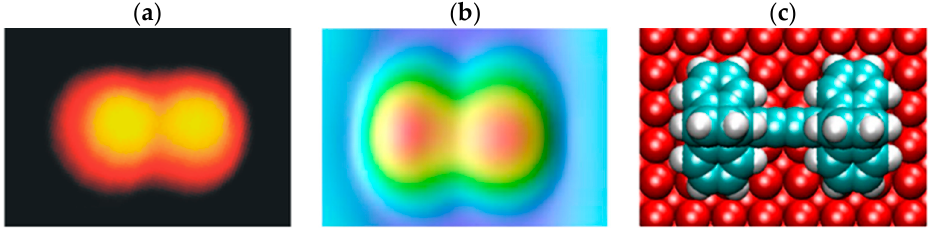
Figure 3. ( a ) Experimental STM image of a wheel dimer on a Cu(110) surface (30 × 30 Å 2 , V = 1 V, I = 0.2 nA) and ( c ) the molecular configuration corresponding to ( b ) the calculated STM image. Adapted from [22], copyright 2006, with permission from Elsevier.